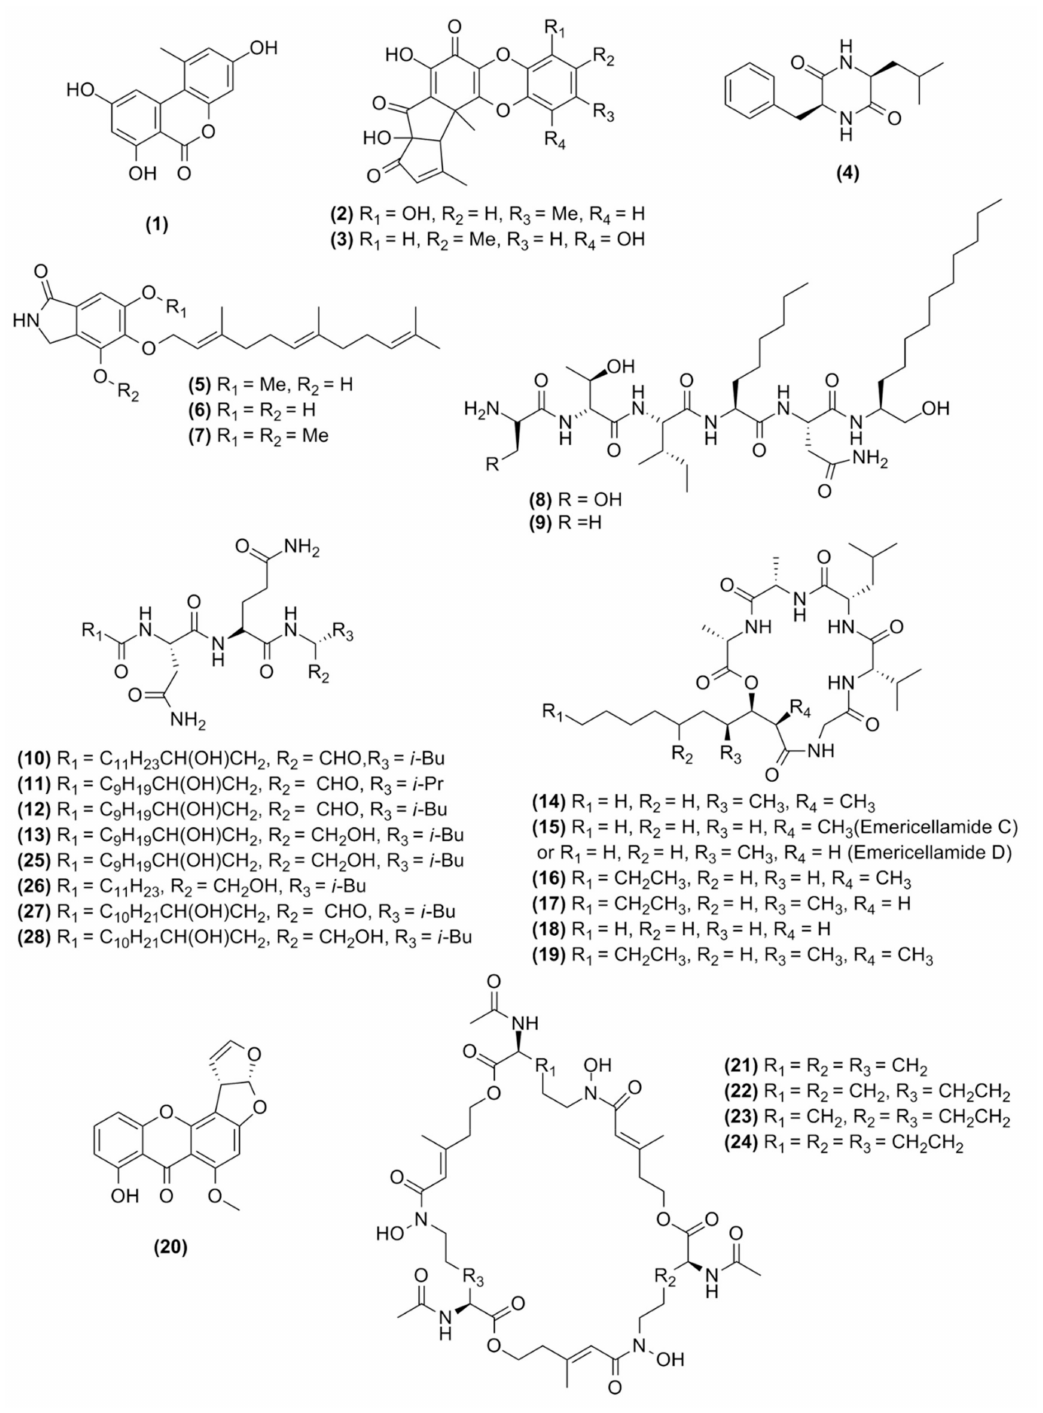
Figure 4. Chemical structure of the molecules observed in this